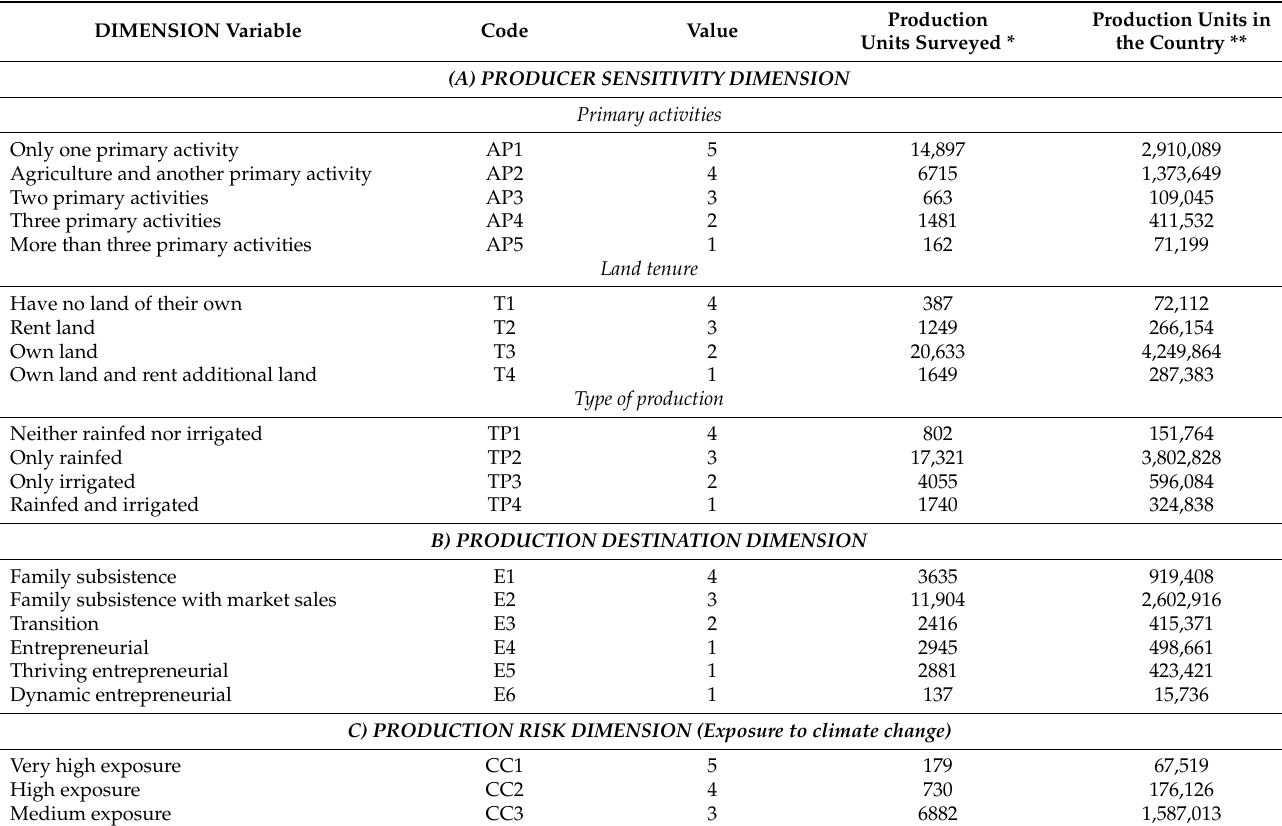
Table 3. Dimensions and variables included in the producer